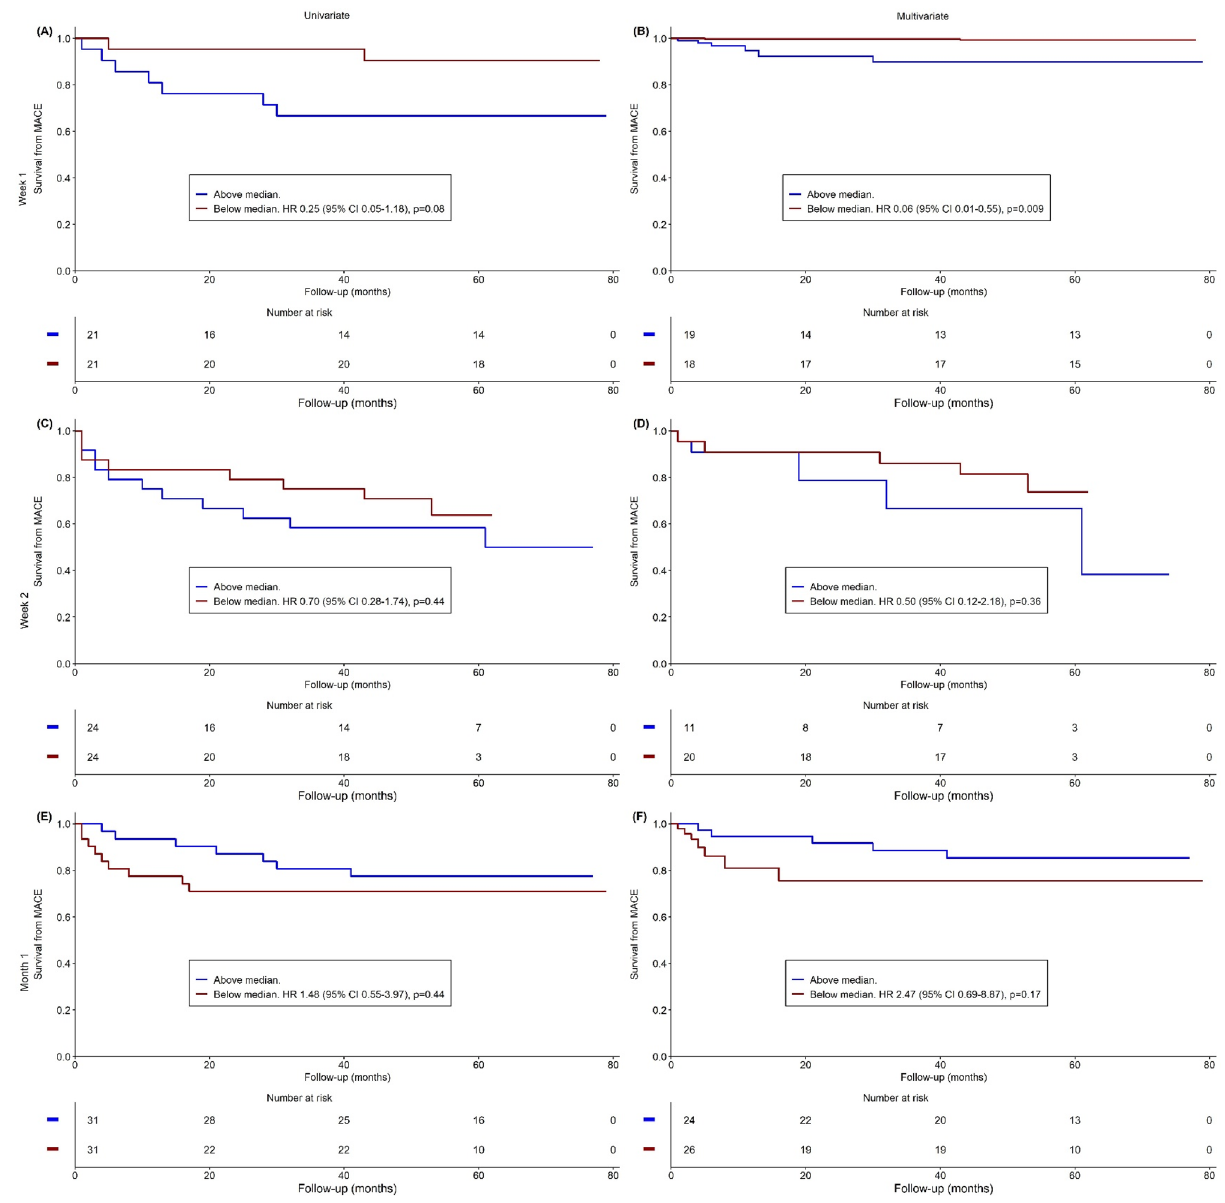
Figure 2. Predictive value of Mon2 for MACE. Univariate (left column) and multivariate (right column) s urvival analyses from MACE in Mon2 according the changes in blood counts of monocyte subsets at one week ( A , B ), two weeks ( C , D ), and one month ( E , F ). MACE Major adverse cardiovascular events, HR Hazard ratio, CI Confidence